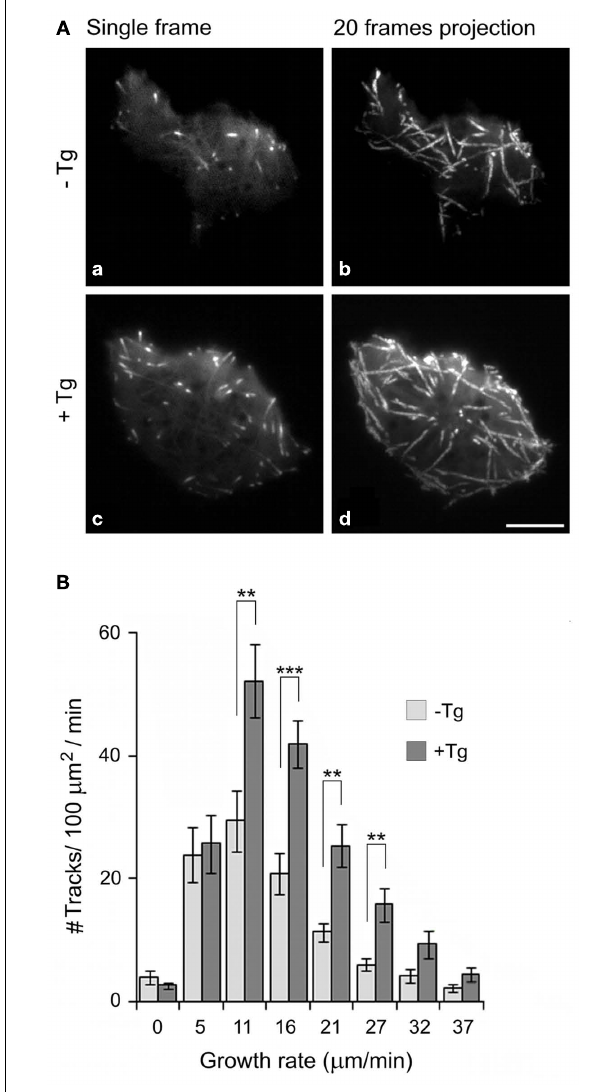
FIGURE 6 | Changes in the number of growing microtubules in cell periphery during mast cell activation as determined byTIRFM time-lapse imaging in living cells. (A) Time-lapse imaging of resting (a,b) and thapsigargin-activated (c,d) BMMCs expressing EB1-GFP. Still images of EB1 (a,c) and tracks of EB1 comets over 20s created by maximum intensity projection of 20 consecutive frames (b,d) . Scale bar, 5 μ m. (B) Histogram of microtubule growth rates in the cell periphery of resting ( − Tg) and thapsigargin-activated ( + Tg) cells. A total of 15 different cells were tracked in five independent experiments.Values indicate mean ± SE, n = 15 (** p < 0.01; *** p < 0.001). Reproduced by permission from reference Hájková et al. (2011). Copyright 2011;The American Association of Immunologists,